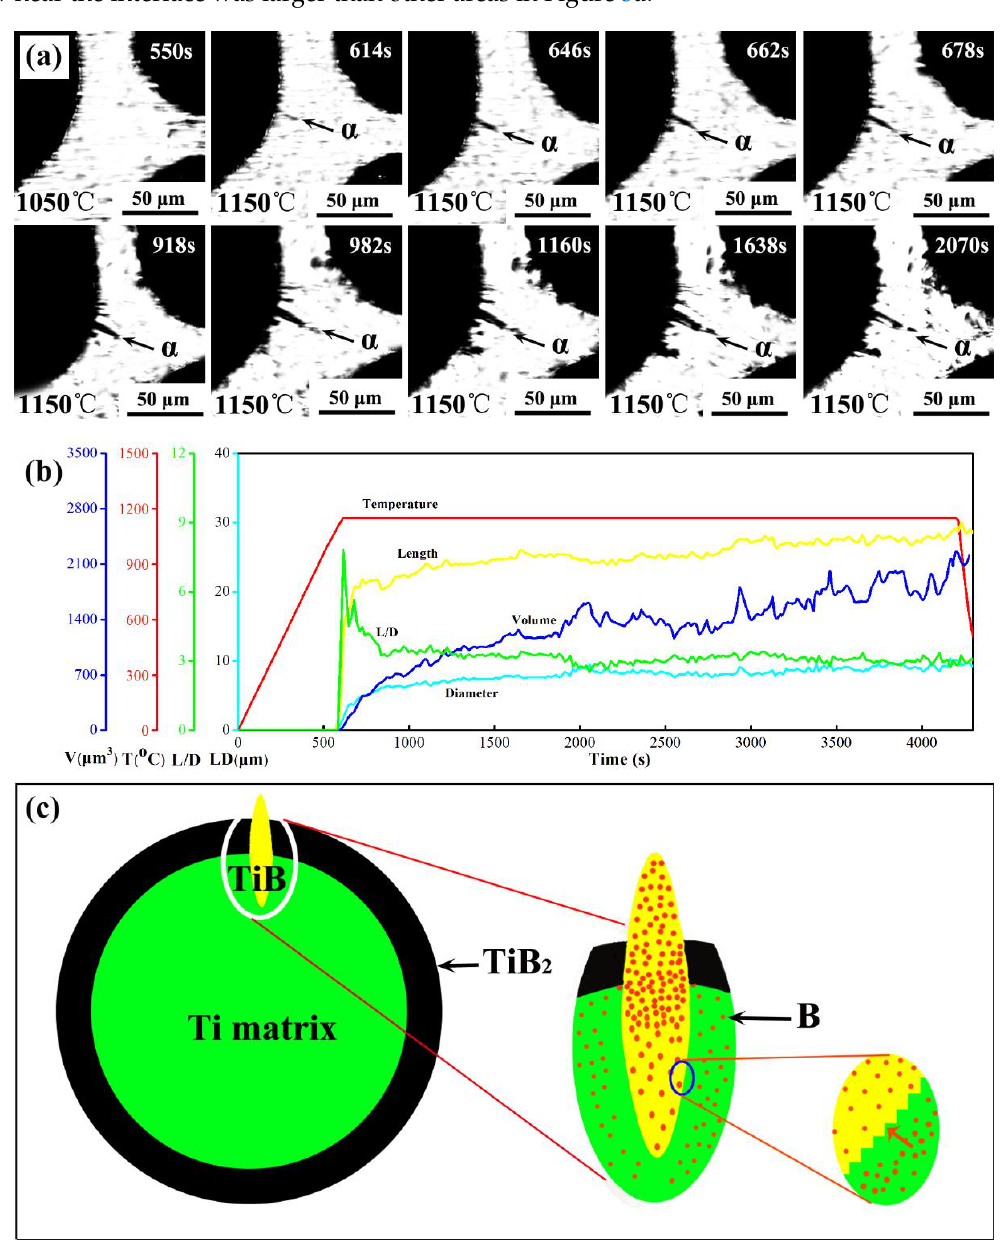
Figure 4. ( a ) The edge image of composites observed by in-situ microscope, ( b ) the curves referred to temperature and length and diameter and volume and length/diameter along heating time, ( c ) the schematic diagram of B atoms in the TiBw and matrix.